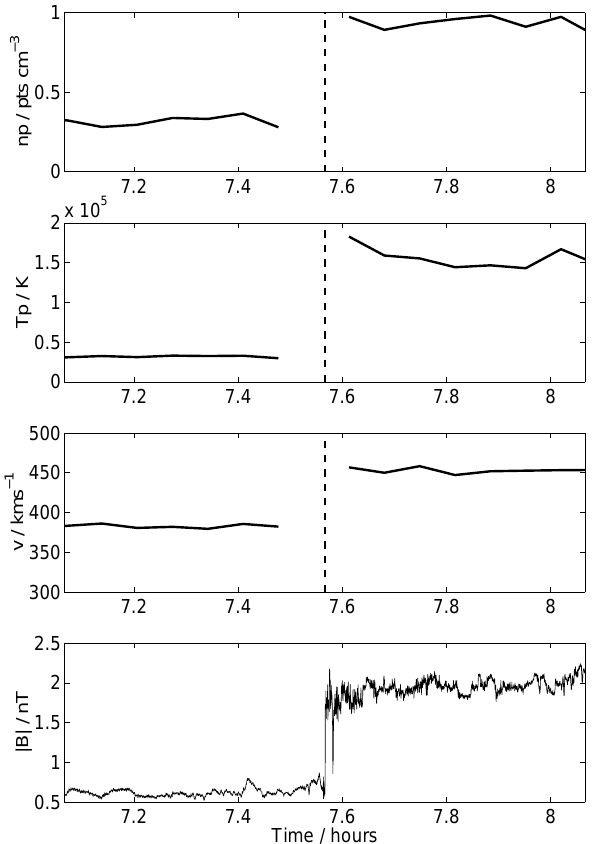
Fig. 3. Magnetic parameters for all shock waves considered in this survey using 10-min averaged data for up and downstream regions and using the magnetic coplanarity method. Top panel: Histogram of θ Bn values. Middle panel: Histogram of α the magnetic deflections. Bottom panel: Histogram of magnetic